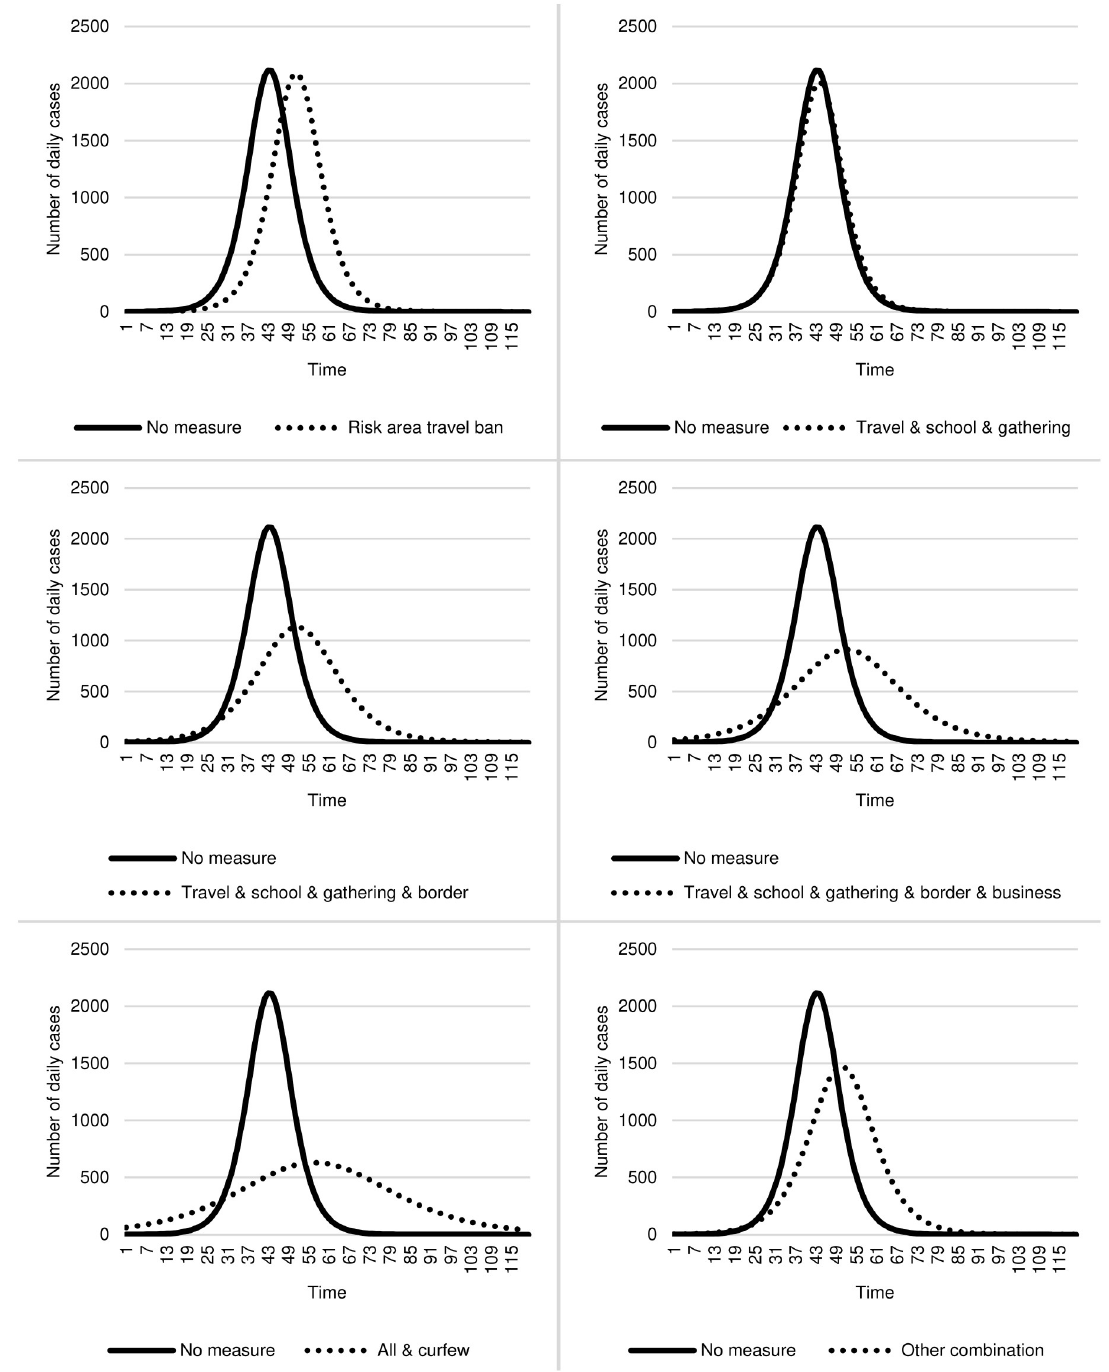
Fig 3. Flatten the curve—The effect of combinations of measures on the containment of the COVID-19 pandemic (incubation of 5 days).